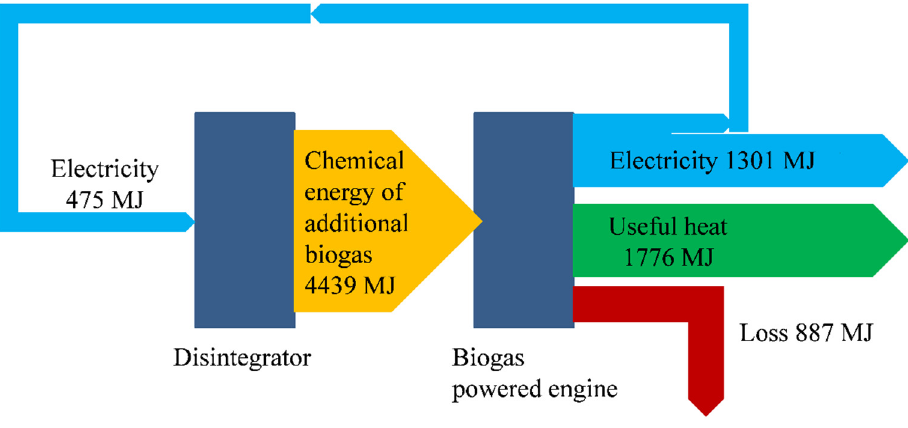
Figure 6. Energy flows in the tested installation.